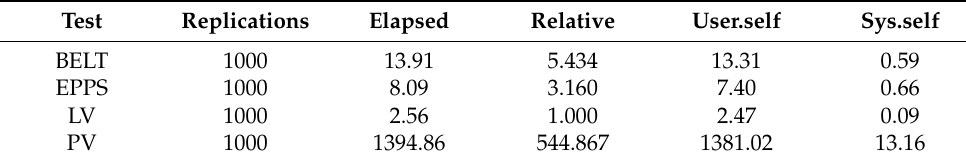
Table 8. Comparisons of computational times (in seconds) for the studied tests. Test Replications